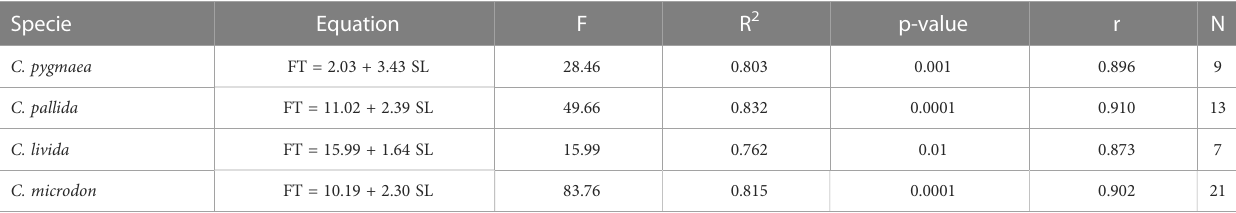
TABLE 4 Equations and parameters of the linear regressions between percentage area with fat tissue (FT) and standard length (SL) for Cyclothone species. Specie